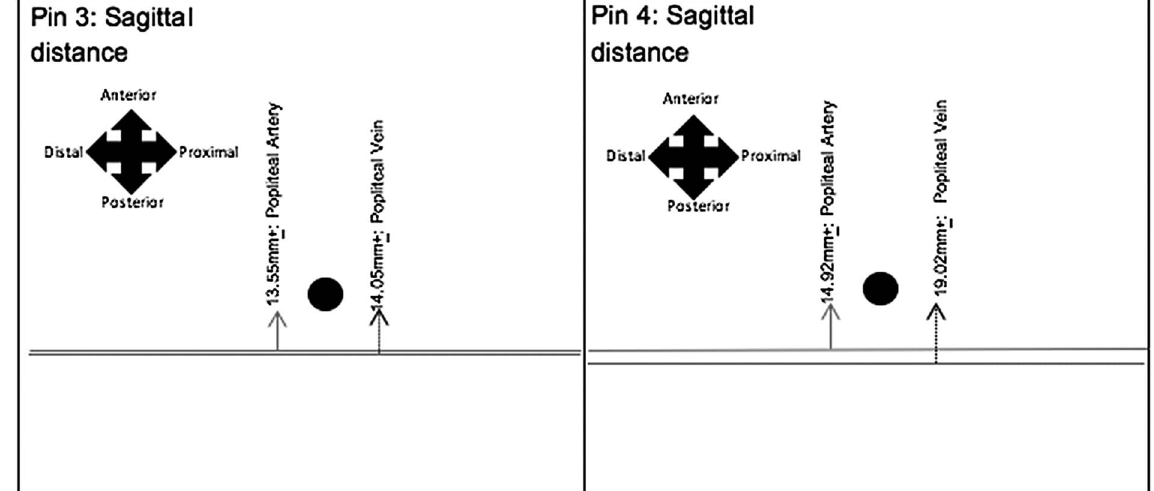
Figure 3. The results obtained for the average sagittal distances between the tips of EF pins 3 and 4, achieved a suitable distance, ranging from 13.55 mm ± 1.09 mm to 19.01 mm ± 1.20 mm; resulting in a lower risk of iatrogenic